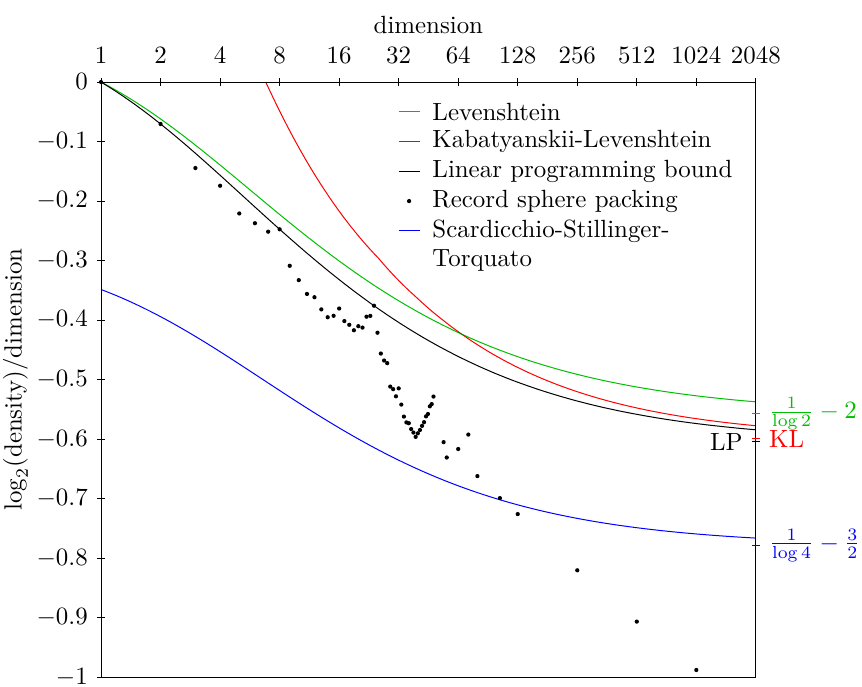
Figure 3 . A comparison of the linear programming bound with other bounds. The annotations on the right show the limits of the colored curves in high dimensions, including our conjectured limit for the linear programming bound from Conjecture